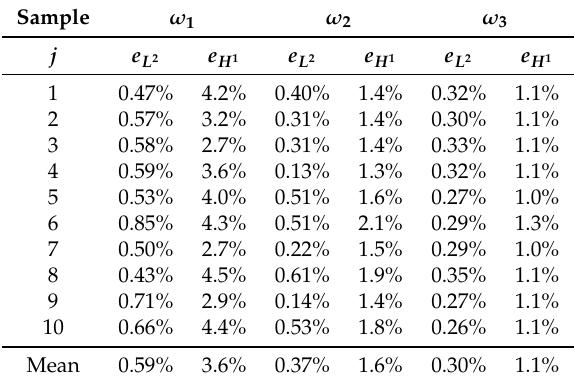
in experiment 1. 2